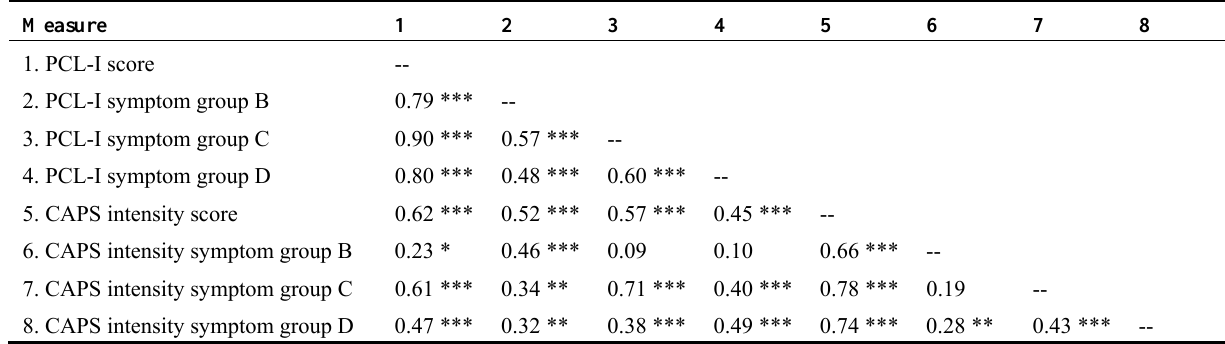
Table 2. Correlation matrix of PCL-I and CAPS intensity